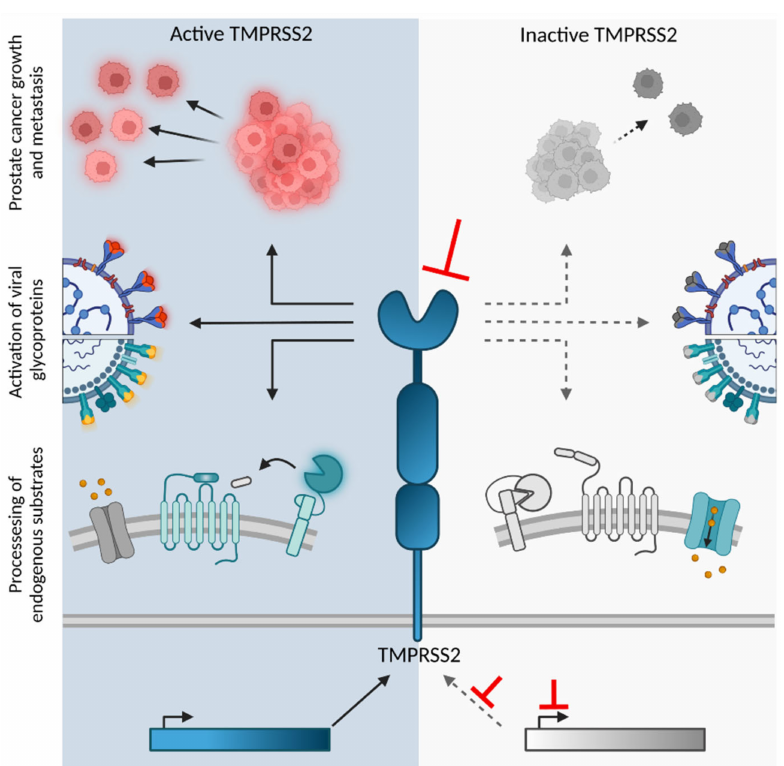
Figure 1. (Patho)-physiological role of TMPRSS2. Left panel: the protease activity of TMPRSS2 contributes to the activation of viral glycoproteins, the progression of prostate cancer, and the cleavage of endogenous substrates such as the epithelial sodium channel, TTSP zymogens, and protease activated receptors. Inhibition of TMPRSS2 expression or protease activity (red arrows, right panel) results in reduced prostate cancer growth and viral entry, although it may also lead to reduced cleavage of endogenous substrates. Figure created with BioRender.com (accessed on 13 December 2021).